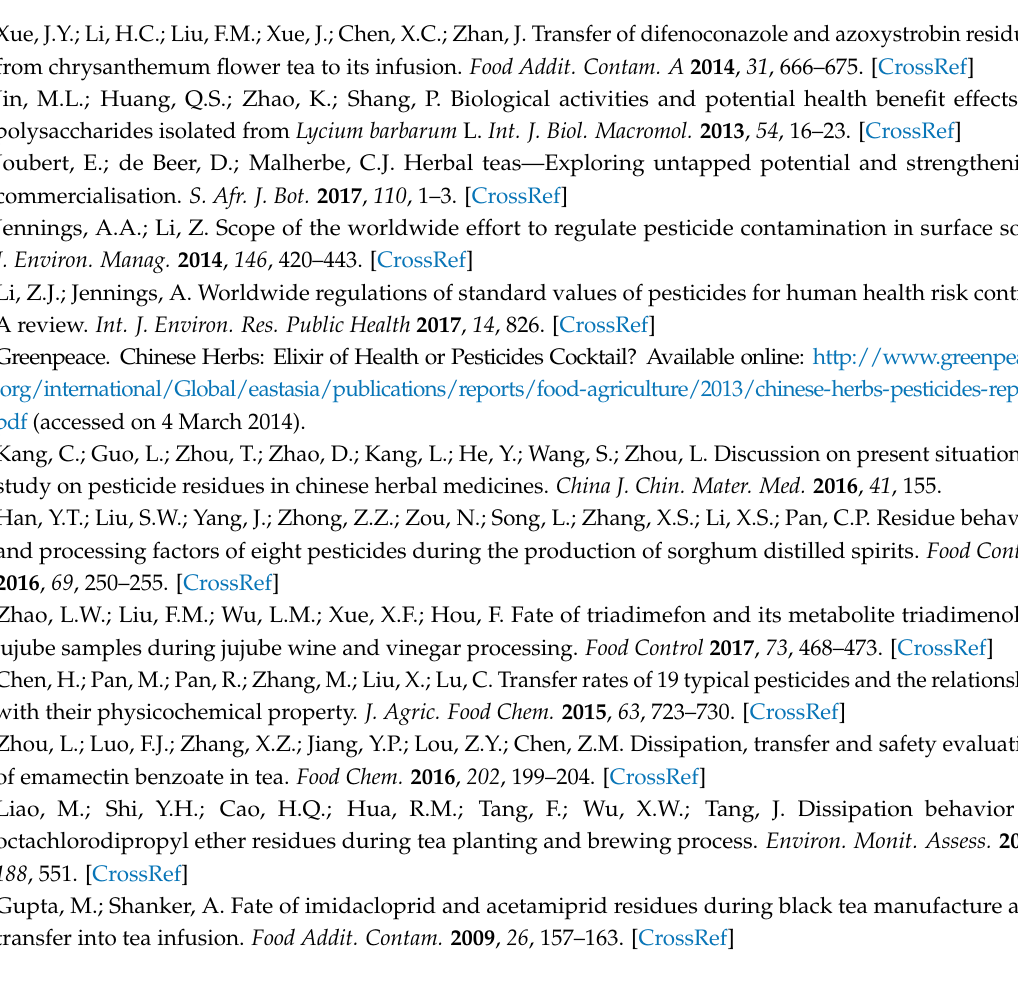
wolfberry, and licorice